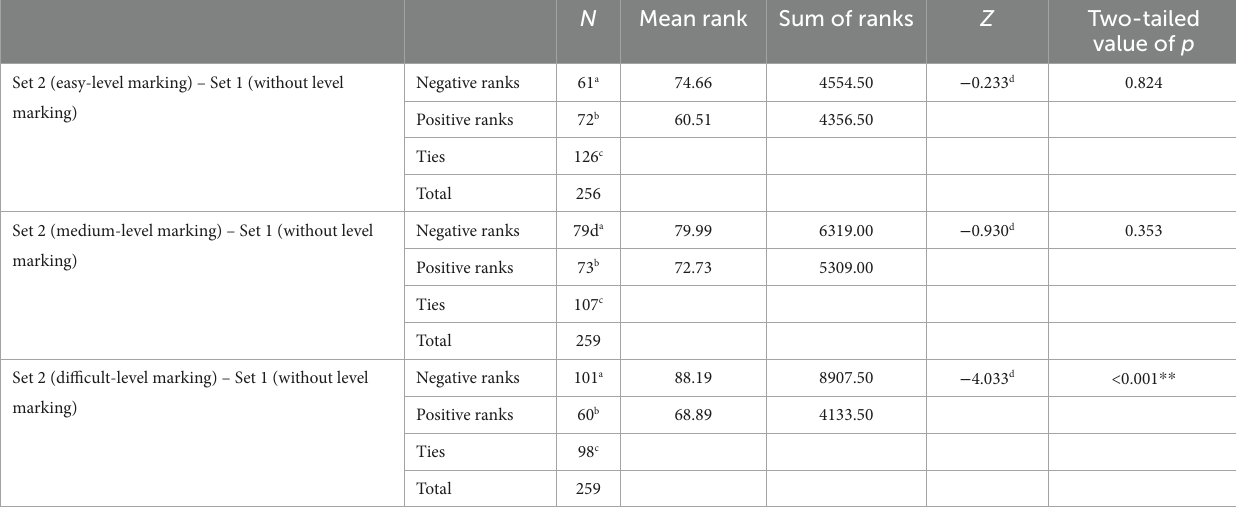
TABLE 4 Wilcoxon test of the difference in students’ self-efficacy (Set 2–Set 1).